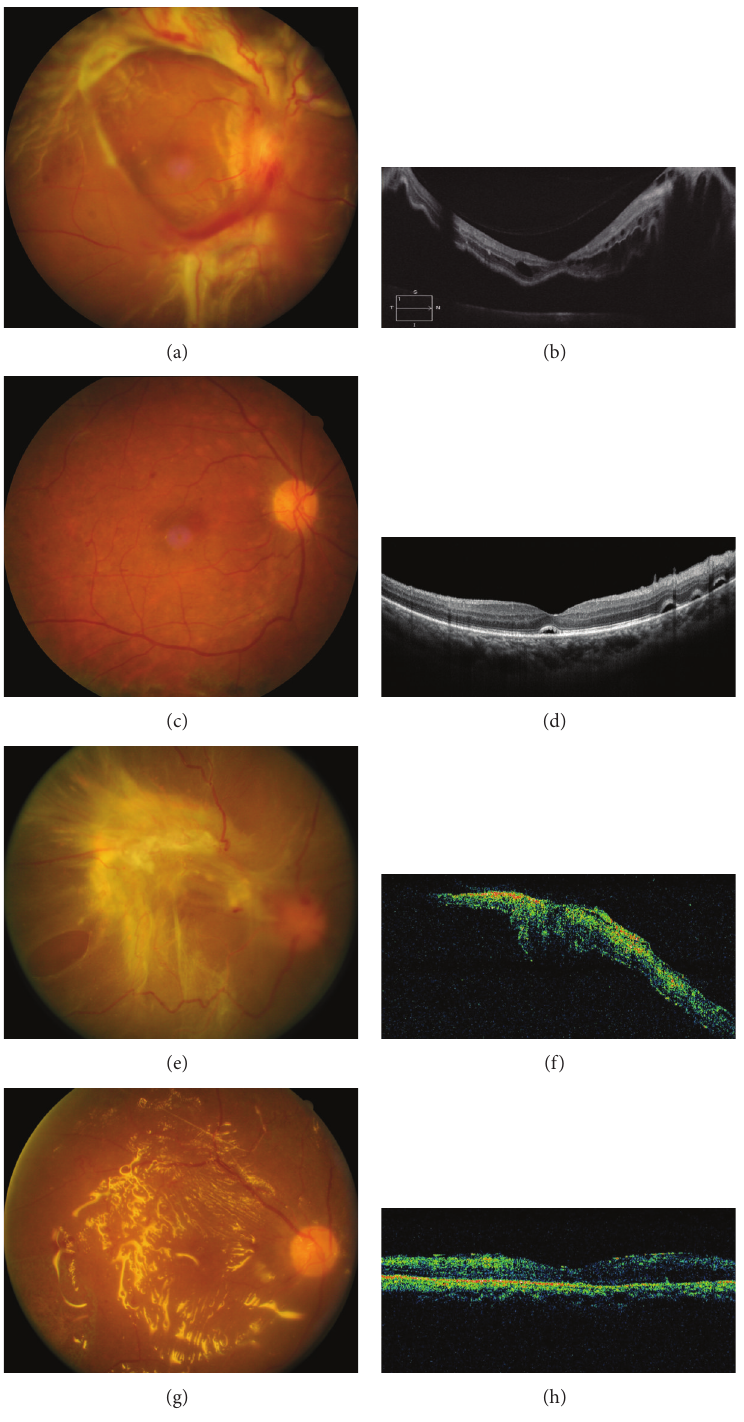
Figure 1: (a–d) Case 47 (right eye). (a) Preoperative fundus photo showed active fibrovascular proliferation of Grade 3 severity; (b) preoperativeopticalcoherencetomographyshoweddetachedretina;(c)postoperativefundusphotoshowedretinalattachment2monthsafter surgery; (d) postoperative OCT revealed flat central retina with residual subretinal fluid pockets. (e–h) Case 19 (right eye). (e) Preoperative fundus photo showed chronic fibrosis of Grade 3 severity. A large oval-shaped retinal break at temporal side was noted; (f) preoperative OCT showed elevated retina at the macular area; (g) postoperative fundus photo showed retinal attachment with silicone oil tamponade 1 month after surgery; (h) postoperative OCT revealed attached retina with thin epimacular